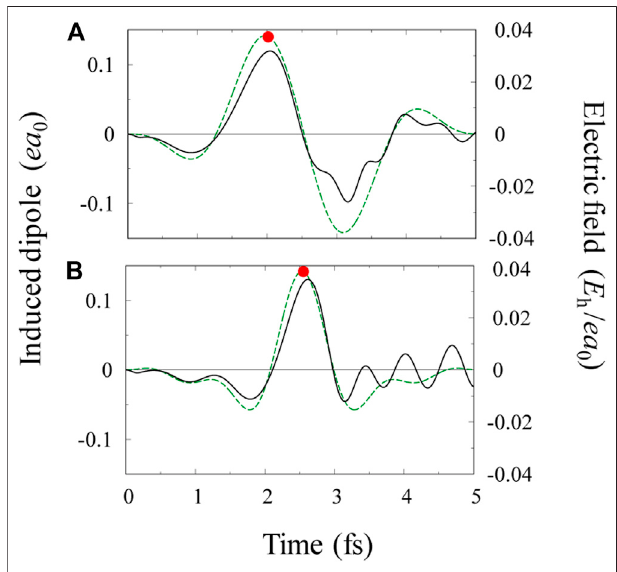
FIGURE 1 | (A) Electric fi eld pro fi le ε 1 ( t ) of the applied two-cycle pulse (15) of ω (cid:2) 0 . 06 E h / Z with CEP of φ 1 (cid:2) 0 . 5 π ; (B) the asymmetric ω +2 ω two- color fi eld with φ 1 (cid:2) φ 2 (cid:2) 0 and a 2 (cid:2) 2 / 3 (both are denoted by green broken lines).